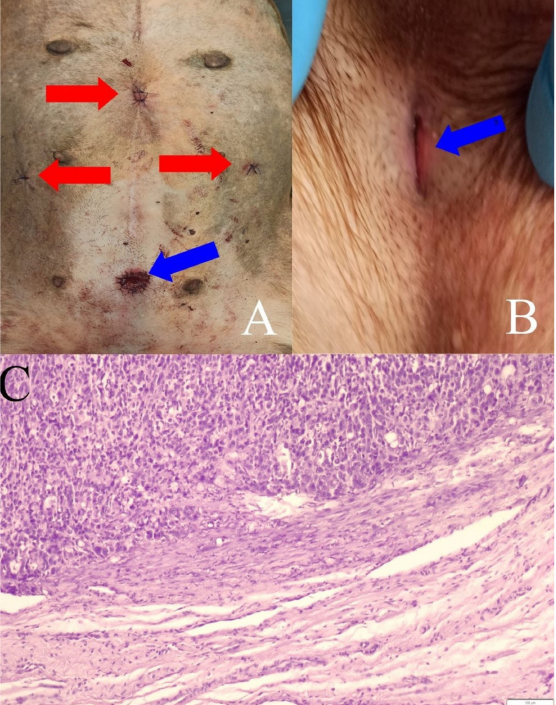
Figure 3. ( A ) Postoperative trocar wounds—red arrows, and prepubic urethrostomy wounds—blue arrow. ( B ) Prepubic urethrostomy image two months after surgery (blue arrow—urethrostomy). ( C ) Transitional carcinoma cells at the border of healthy connective tissue. HE staining, 100 × (scale bar 100 µ